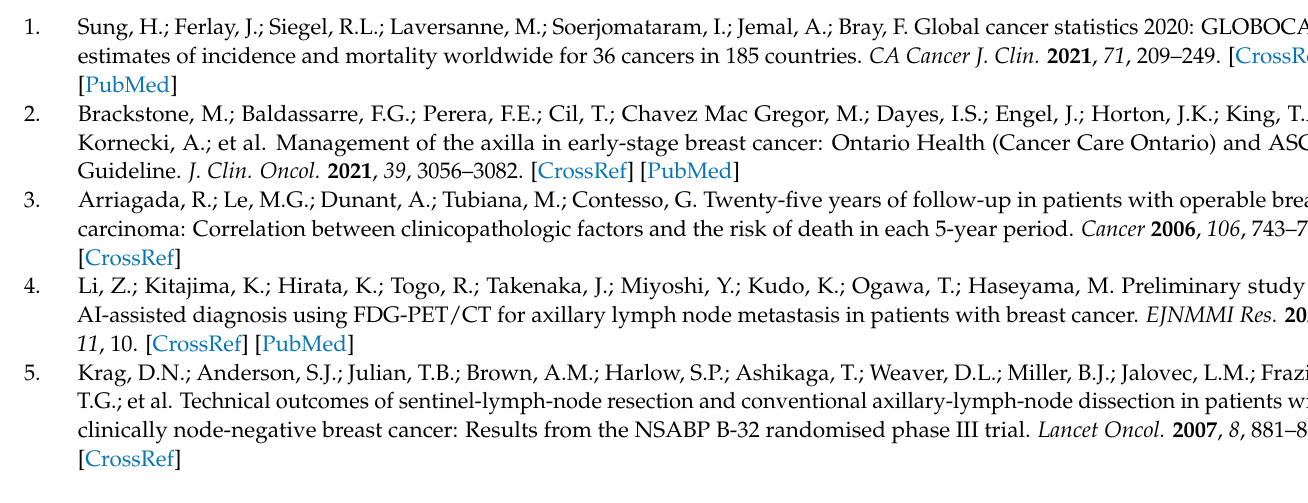
metastasis, Table S4. Correlation of the primary tumor size with the 38 textural features of peritumoral breast adipose tissue, Table S5. Correlation of molecular subtypes of the primary tumors with the 38 textural features of peritumoral breast adipose tissue, Table S6. Diagnostic ability of the primary tumor parameters and textural features of FDG PET/CT with AUC values < 0.750 for predicting axillary lymph node